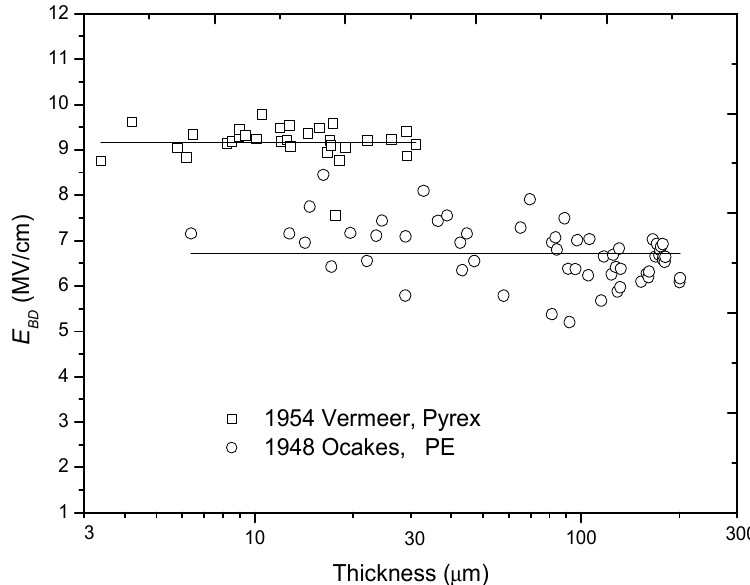
Figure 1. Experimental results supporting the constant relation of the dielectric field E BD with thickness d . The constant relation of E BD on d may reflect some intrinsic breakdown characteristics of